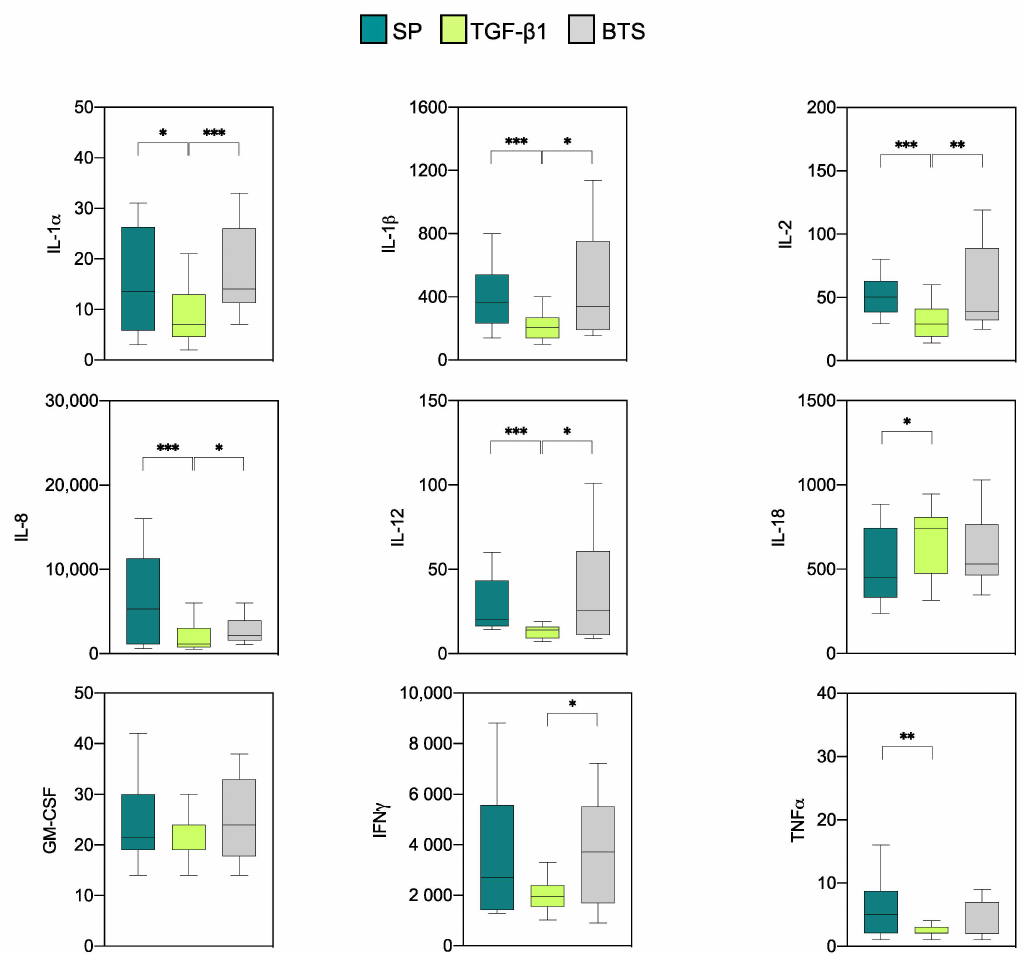
Figure 2. Levels of proinflammatory cytokines (pg/mL) on day 6 of pregnancy in endometrial explants of “donor” sows infused with 40 mL of SP, TGF- β 1 in BTS extender (TGF- β 1), or BTS alone (control) 30 min prior to insemination. The box plots show the median (line) and the interquartile ranges (boxes, Q1–Q3). * p < 0.05, ** p < 0.01, *** p <